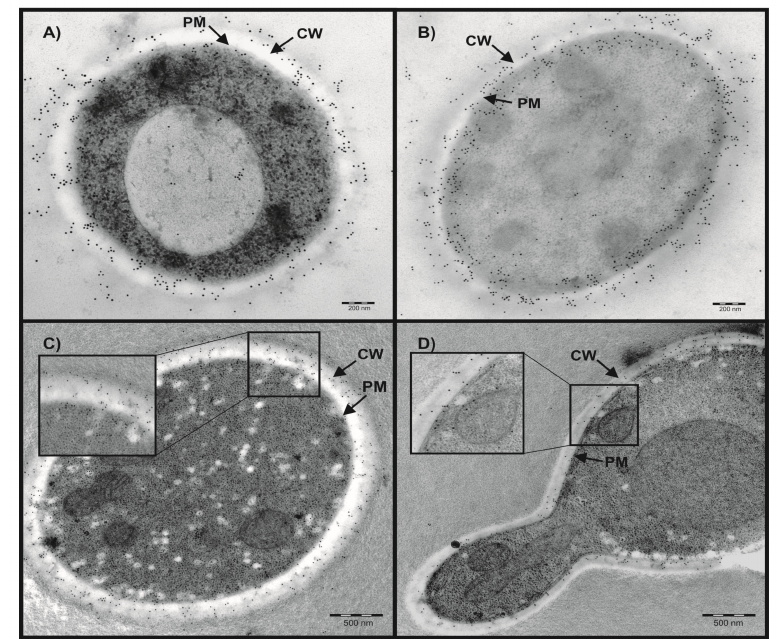
Figure 1. Localization of Nce103p using immunogold labeling and electron microscopy. ( A , C ) C. parapsilosis ; ( B , D ) C. albicans ; CW: cell wall, PM: plasma membrane. Scale bars, 200 nm and 500 nm. Panels C and D contain also zoom-in sections of the outer parts of the cells.